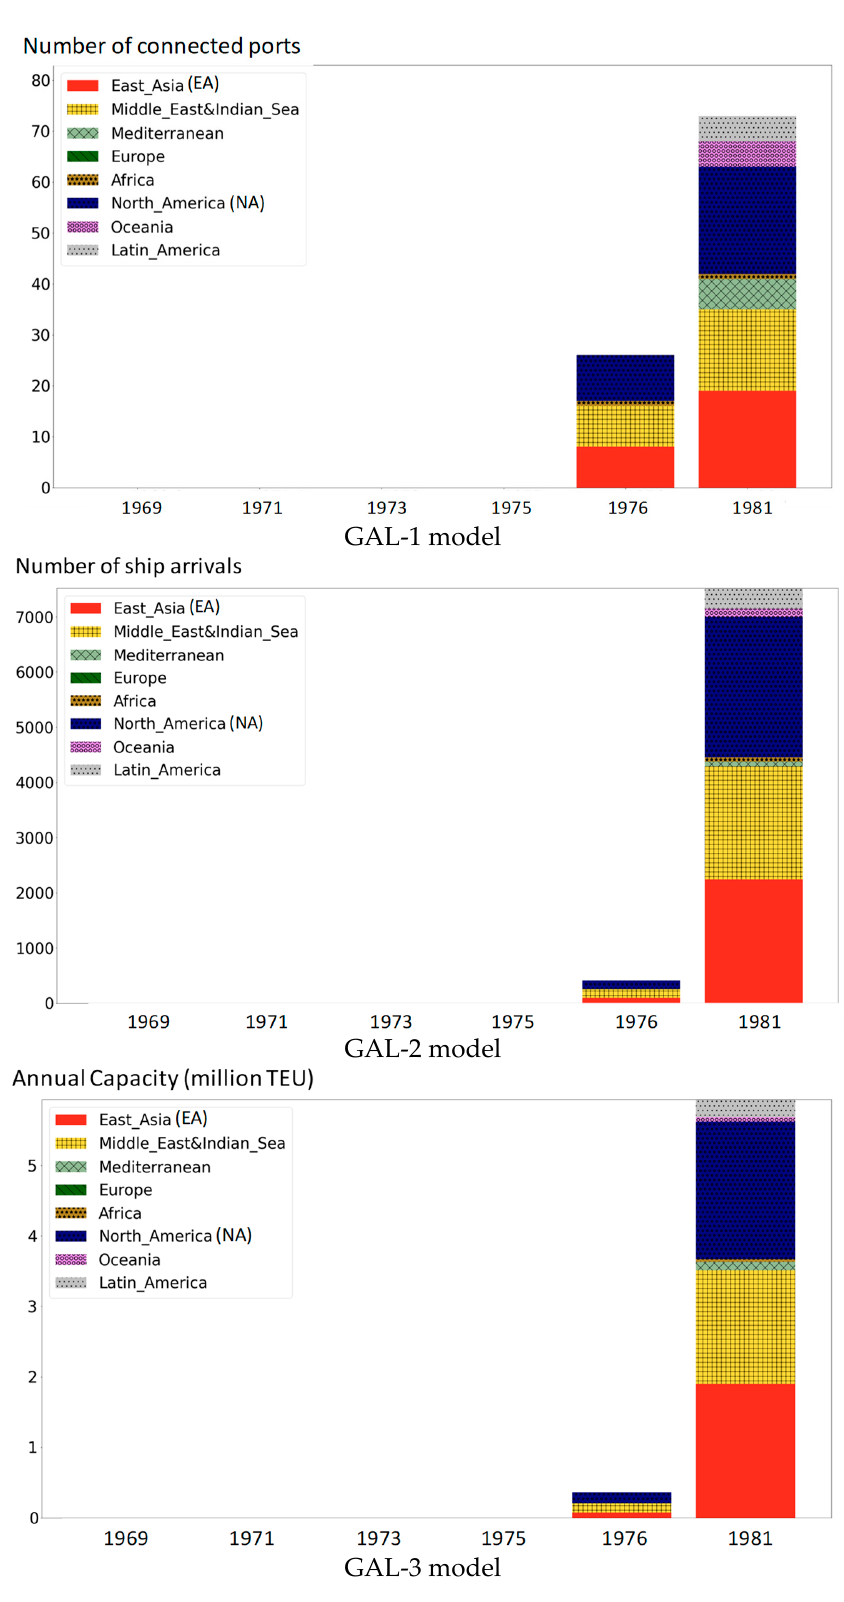
Figure 14. (Weighted) number of connected ports and regional breakdown in the port of Dubai (1969–1981).